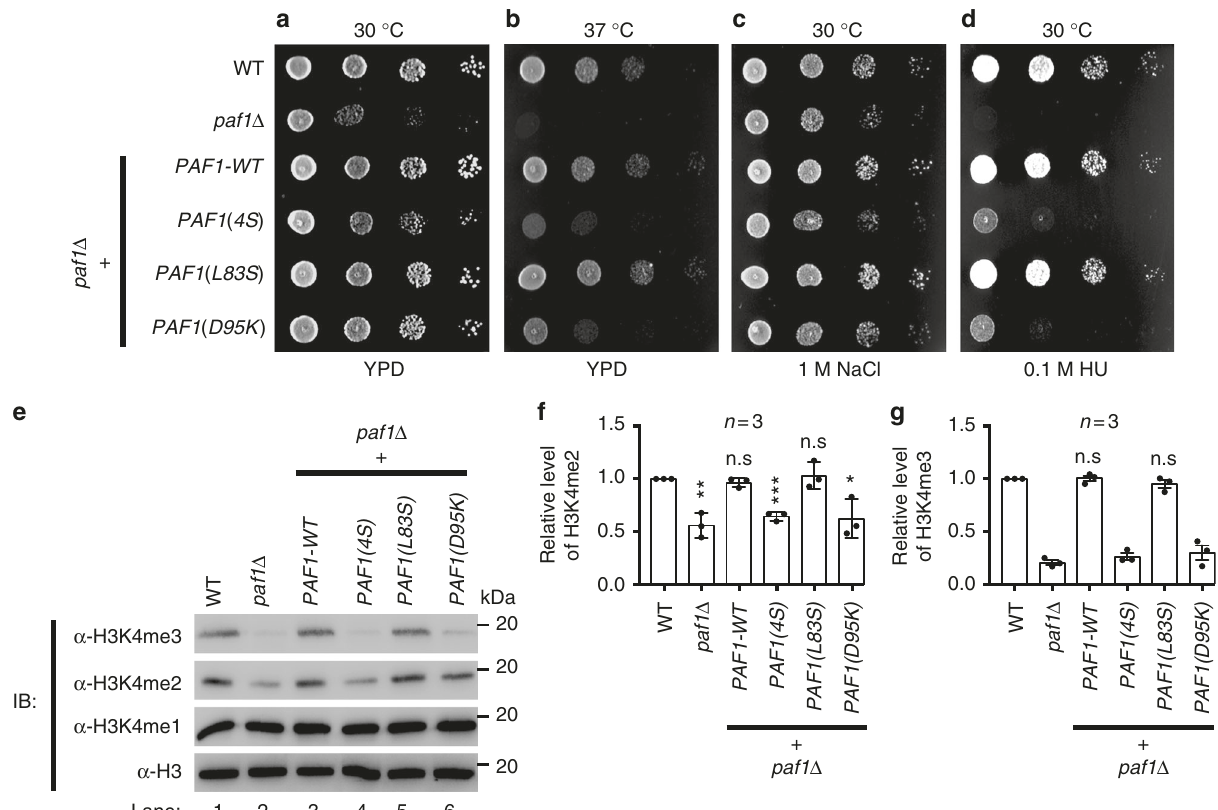
Fig. 7 Ctr9/Paf1 subcomplex formation is essential for the integrity of a functional yeast Paf1C. a – d Ctr9/Paf1 subcomplex-mediated Paf1C assembly is essential for yeast cell viability. Strains of the indicated genotype were grown to late log phase/stationary phase (overnight) and plated in serial dilutions on a YPD plate. The plates are shown after 40 h of incubation at 30 °C ( a ), at 37 °C ( b ), on YPD containing 1 M NaCl ( c ), and on YPD containing 0.1 M hydroxyurea (HU) ( d ). e Representative immunoblot with speci fi c H3K4me1/2/3 antibodies to detect methylation strength (top panels), or with H3 antibody to demonstrate equal loading (bottom panel). Bar graphs of H3K4me2 ( f ) and H3K4me3 levels ( g ) from various yeast strains, as indicated. All statistic data in this fi gure represents the results from three independent batches of experiments. Error bars represent s.e.m. ( n = 3). * P < 0.05, ** P < 0.01, *** P < 0.001. Uncropped blots are shown in Supplementary Fig.